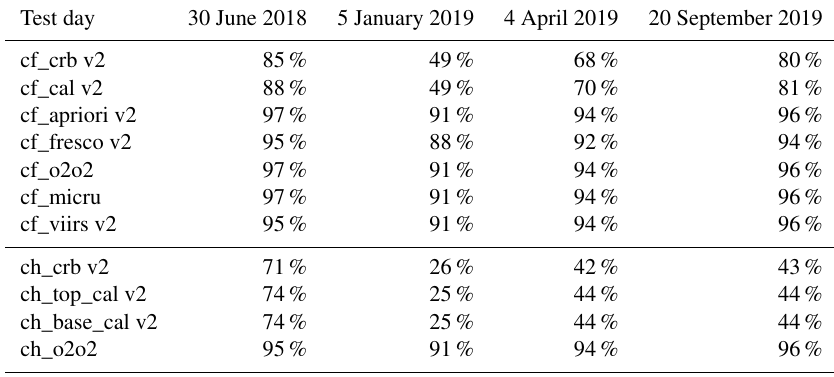
Table B3. As Table B1 but in the region of China.